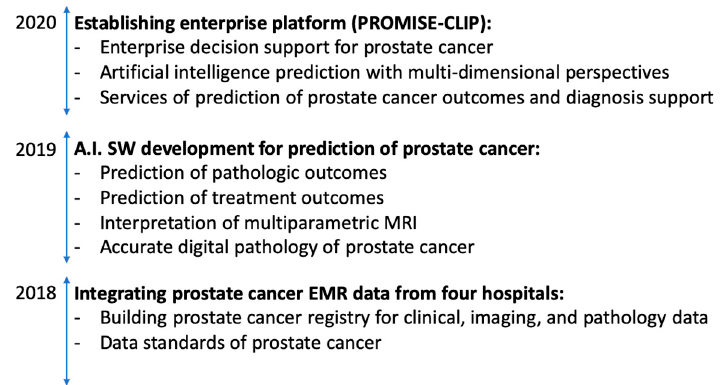
Figure 1. The PROstate Medical Intelligence System Enterprise-Clinical, Imaging, and Pathology (PROMISE CLIP)